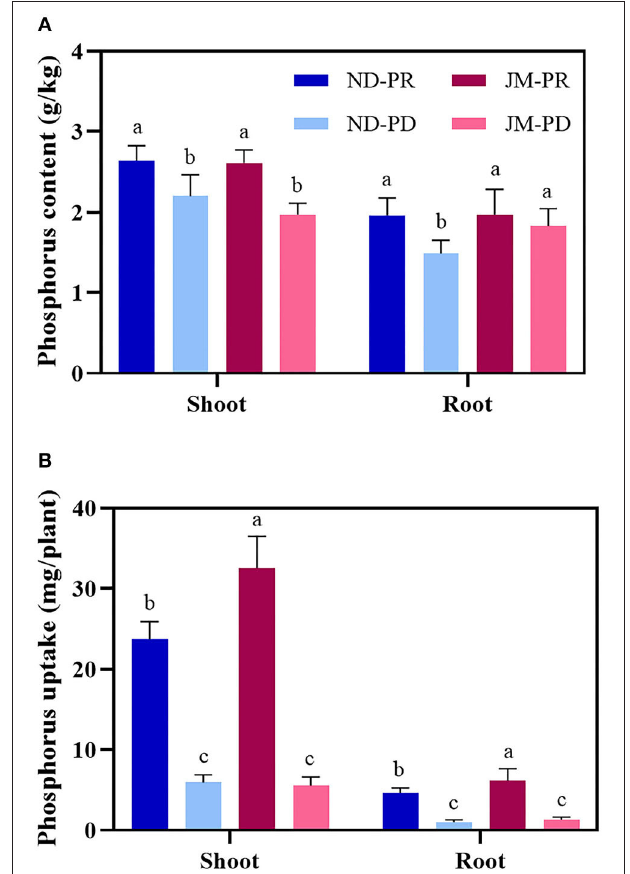
FIGURE 4 | Phosphorus content (A) and uptake (B) in root and shoot tissues of two cotton cultivars under different phosphorus levels. ND-PR, “Nongdamian No. 10” cultivar under replete phosphorus conditions; ND-PD, “Nongdamian No. 10” cultivar under low phosphorus; JM-PR, “Jimian 315” cultivar under replete phosphorus conditions; JM-PD, “Jimian 315” cultivar under low phosphorus. Depicted are the means of six replicates ± standard errors. For each trait, bars with the same letter are not significantly different according to Duncan’s test at a P < 0.05